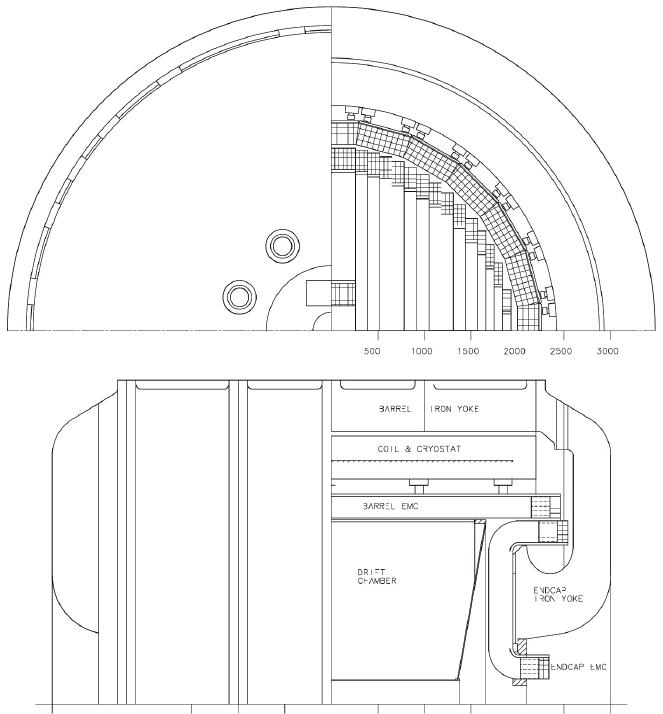
Figure 120. Front ( top ) and side ( bottom ) view of the calorimeters showing the light guides and their location inside the KLOE magnet. The units are in